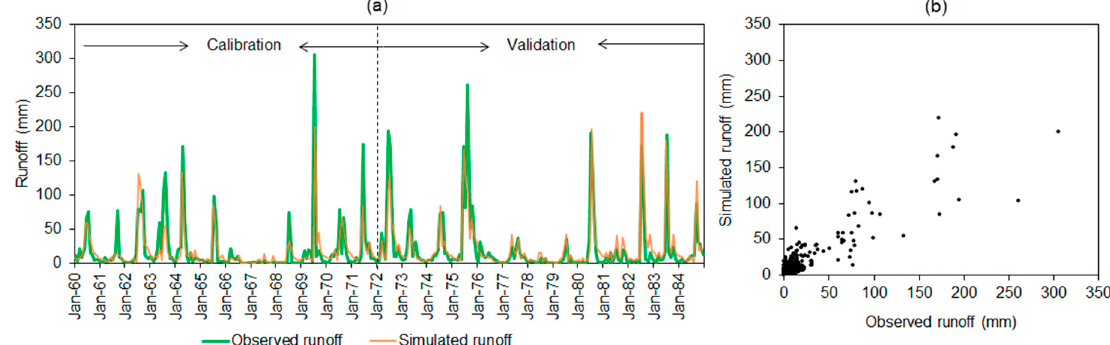
Figure 7. Comparison of the observed and simulated runoff in the Qingliu River for the calibration (1960–1971) and validation (1972–1984) periods ( a ), and the scatter plot of the observed versus simulated runoff ( b ). Jan means January. Table 5. Performance of the SWAT model for runoff simulation for the Qingliu River basin, East China. Indicator